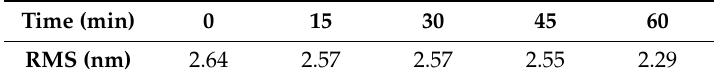
Table 3. RMS values of the planar n-Si/PEDOT:PSS films with different exposure times.